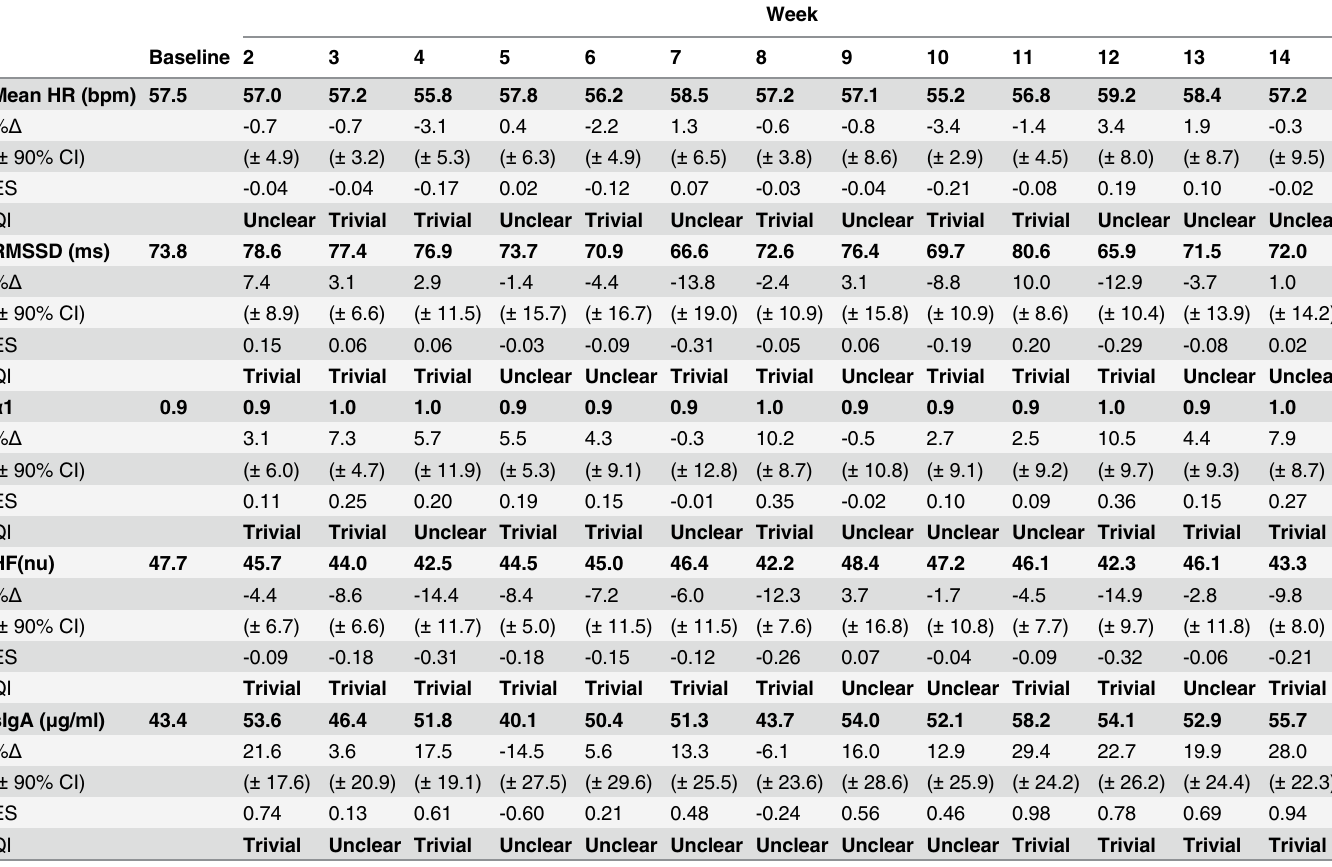
Table 3. Mean values, variance from baseline, Cohen ’ s effect size (ES) and qualitative inferences for heart rate variability and saliva measures dur- ing the 14 week monitoring period.